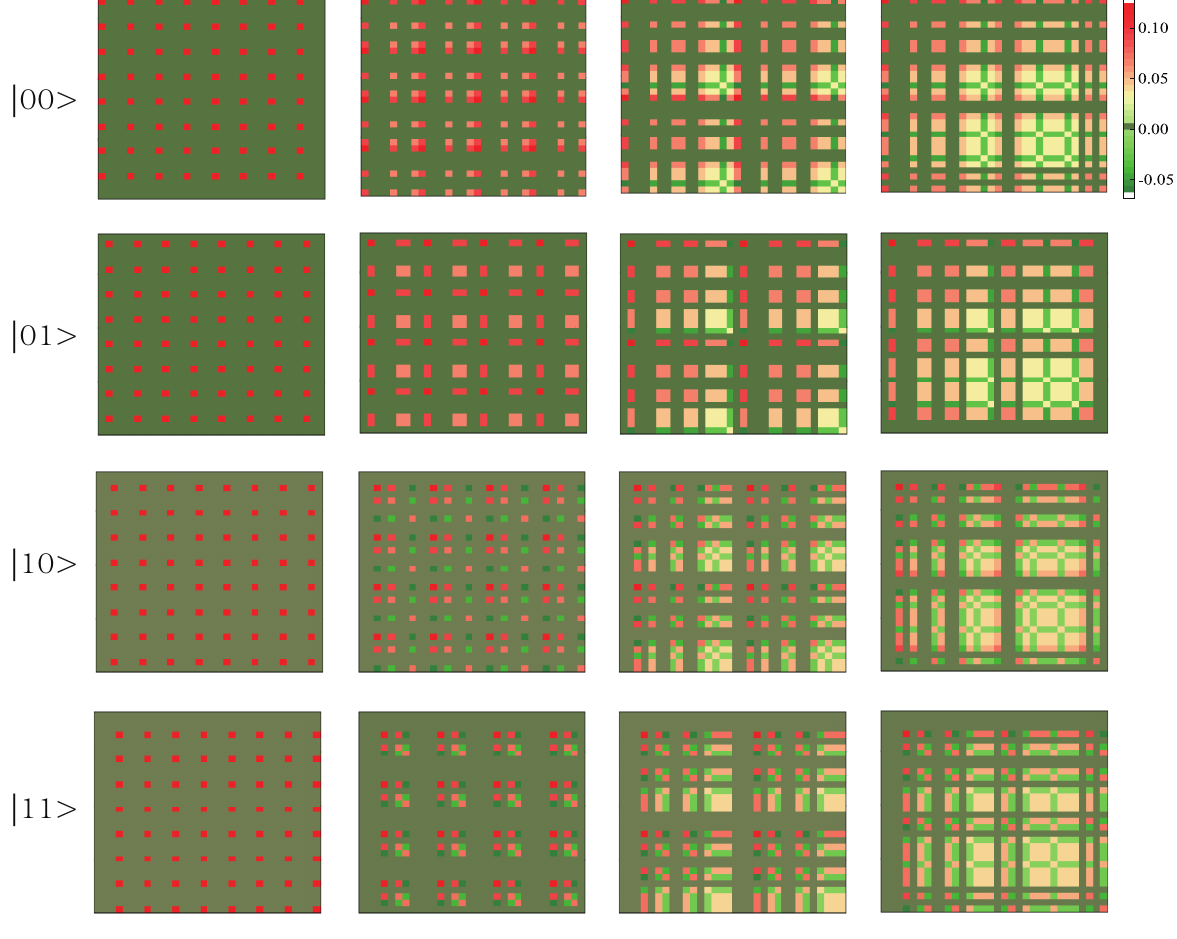
Figure A1. Density matrices of quantum states during the processing. Input states are | 0 (cid:105) | 0 (cid:105) (cid:78) 3 | 01 (cid:105) , | 0 (cid:105) (cid:78) 3 | 10 (cid:105) , and | 0 (cid:105) (cid:78) 3 | 11 (cid:105) . From the left to right are ρ